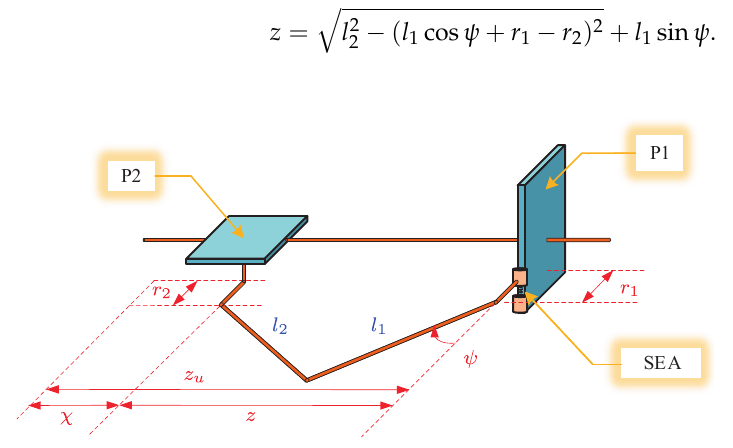
Figure 3. Model of the stable platform with the